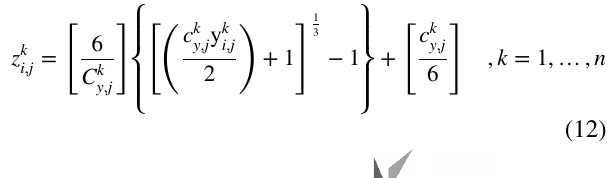
Fig. 8 Historical and generated monthly skewness coefficients of flows in Barakar River (single-site